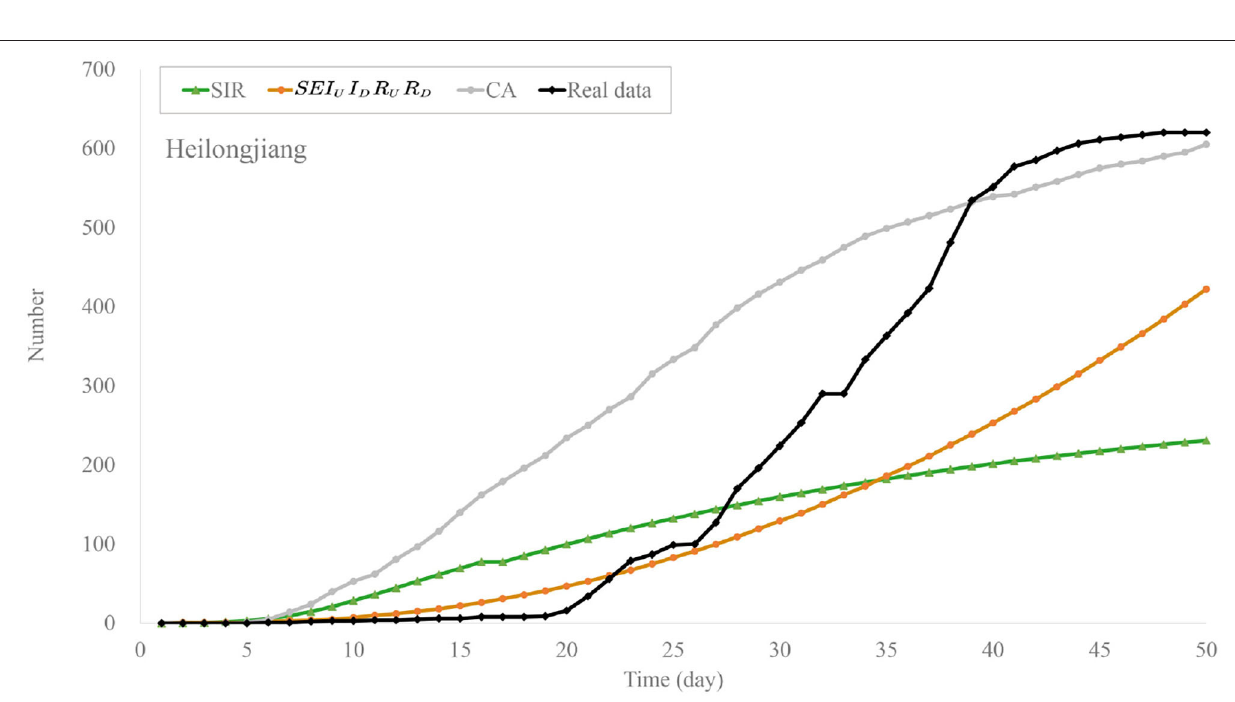
Frontiers in Public Health | www.frontiersin.org 6 July 2022 | Volume 10 | Article